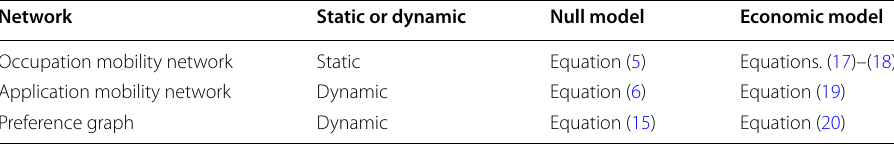
Table 3 Connections between null models and economic gravity models